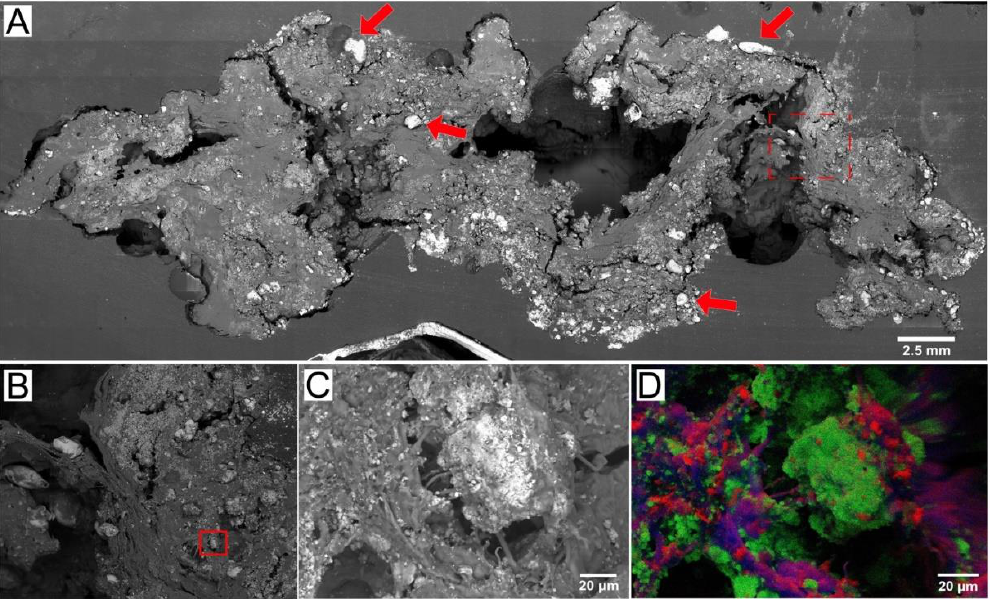
Figure 2. SEM and EDS images of microbial – carbonate interactions in a microbial mat. ( A ) SEM of a peritidal pustular mat from Shark Bay, Australia. Arrows point to the aragonite grains trapped by the mat. Red box (dashed) shows the area enlarged in panel ( B ). ( B ) Enlarged view of the area outlined by the red box in panel ( A ). Red box shows the area enlarged in panel ( C ). ( C ) Microcrystalline aragonite that precipitates in EPS, some cyanobacterial filaments are also visible. ( D ) EDS map of carbon (red), calcium (green), and sulfur (blue) of the region shown in panel ( C ).